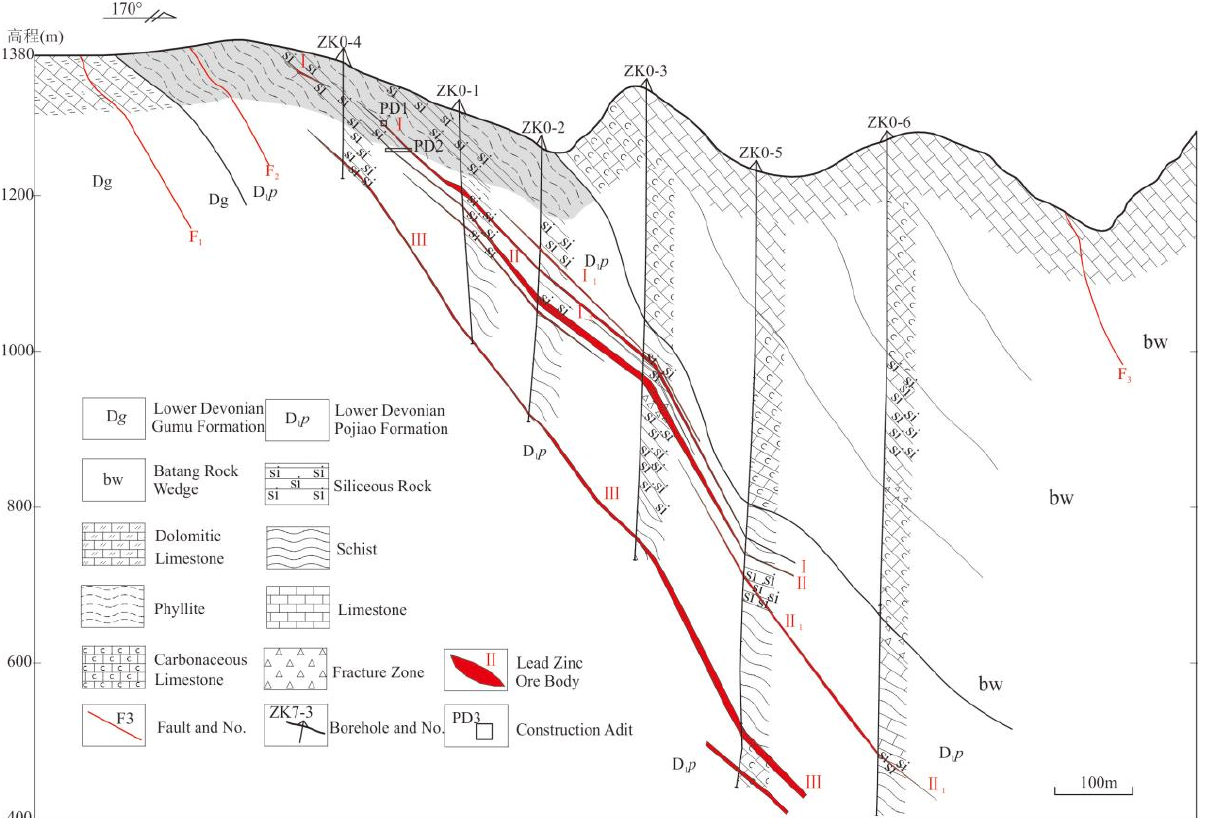
Figure 3. Profile of exploration line 0# in the Caiyuanzi Pb–Zn mining area.